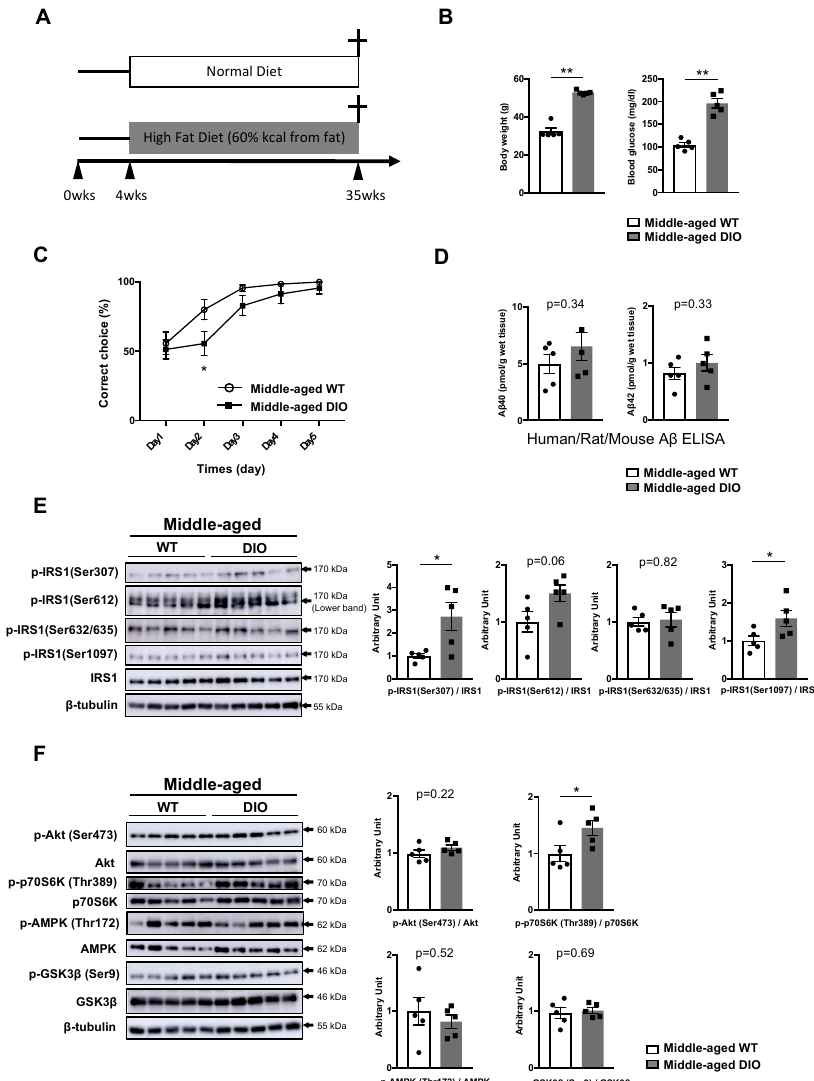
Figure 1. Changes in specific Ser sites on hippocampal insulin receptor substrate 1 (IRS1) in type 2 diabetes (T2DM)-induced memory impairment. ( A ) Schematic diagram of the experimental procedure. ( B ) Graphs of body weight and blood glucose level in wild-type (WT) and diet-induced obesity (DIO) mice (35 weeks of age, n = 5 mice per group). ( C ) Evaluation of learning memory function in middle-aged WT and DIO mice (n = 14 mice per group) using the water T-maze test. ( D ) Quantitative analysis of T-PER (Tissue Protein Extraction Reagent)-extractable A β 40 and A β 42 levels in the hippocampi of middle-aged WT and DIO mice using the human / rat / mouse β amyloid (1–40 and 1–42) enzyme-linked immunosorbent assay (ELISA) (35 weeks of age, n = 5 biologically independent samples per group). (E) Western blot analysis of phosphorylated insulin receptor substrates 1 mouse Ser307 [p-IRS1 (mSer307)], p-IRS1 (mSer612), p-IRS1 (mSer632 / 635), p-IRS1 (mSer1097), IRS1, and β -tubulin in the hippocampi of middle-aged WT and DIO mice (35 weeks of age, n = 5 biologically independent samples per group). Arrow indicates the p-IRS1 mSer612-corresponding band (lower band) in ( E ). Quantitative analysis of the phosphorylation of IRS1 at mSer307, mSer612, mSer632 / 635, and mSer1097 normalized to total protein. ( F ) Western blot analysis of phosphorylation levels of Akt Ser473, p70S6K Thr389, AMP-activated protein kinase (AMPK) Thr172, and glycogen synthase kinase 3 beta (GSK3 β ) Ser9 as well as total protein levels of Akt, p70 S6K, AMPK, GSK3 β , and ß-tubulin in the hippocampi of middle-aged WT and DIO mice (35 weeks of age, n = 5 biologically independent samples per group). Quantitative analysis of the phosphorylation of Akt Ser473, p70S6K Thr389, AMPK Thr172, and GSK3 β Ser9 normalized to the respective total protein contents. Results are presented as mean ± standard error of the mean (SEM), * p < 0.05; ** p <